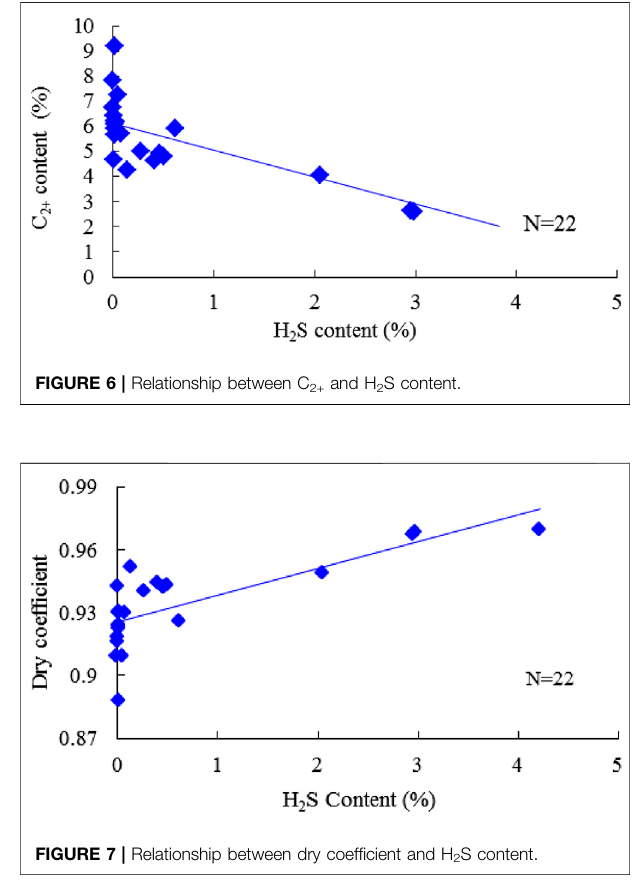
Frontiers in Earth Science |